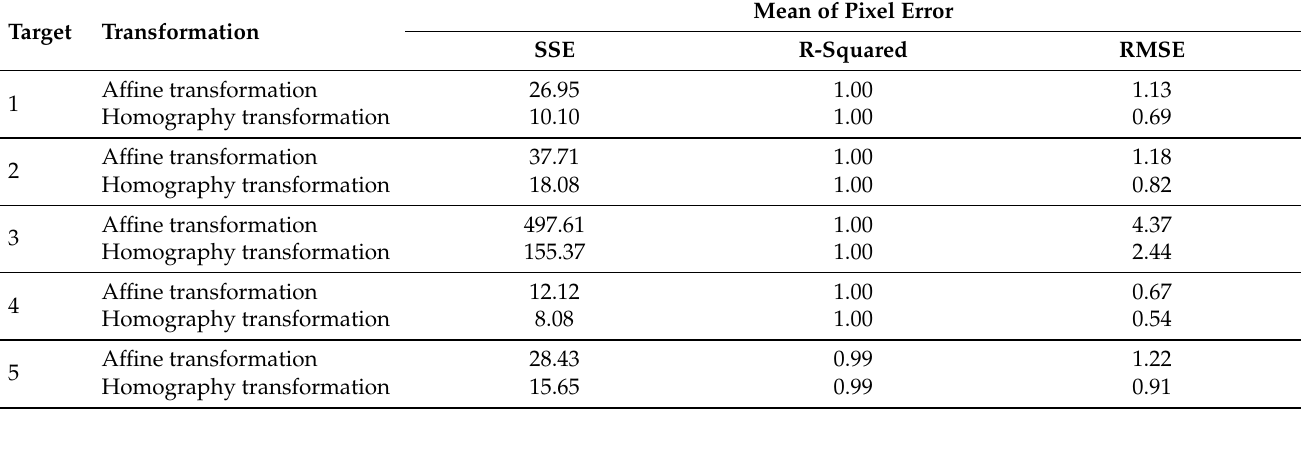
Table 7. Comparison of trajectory fitting by different transformations.